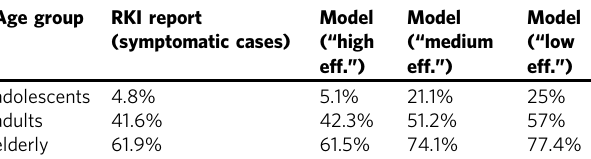
Table 1 Share of breakthrough infections in the age groups eligible for vaccination according to of fi cial estimates by